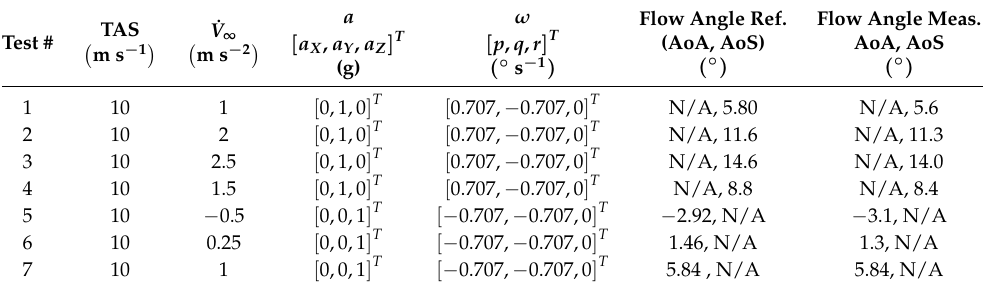
Table 2. Numerical ASSE estimation exciting both the accelerometer and the gyroscope with steady state values.